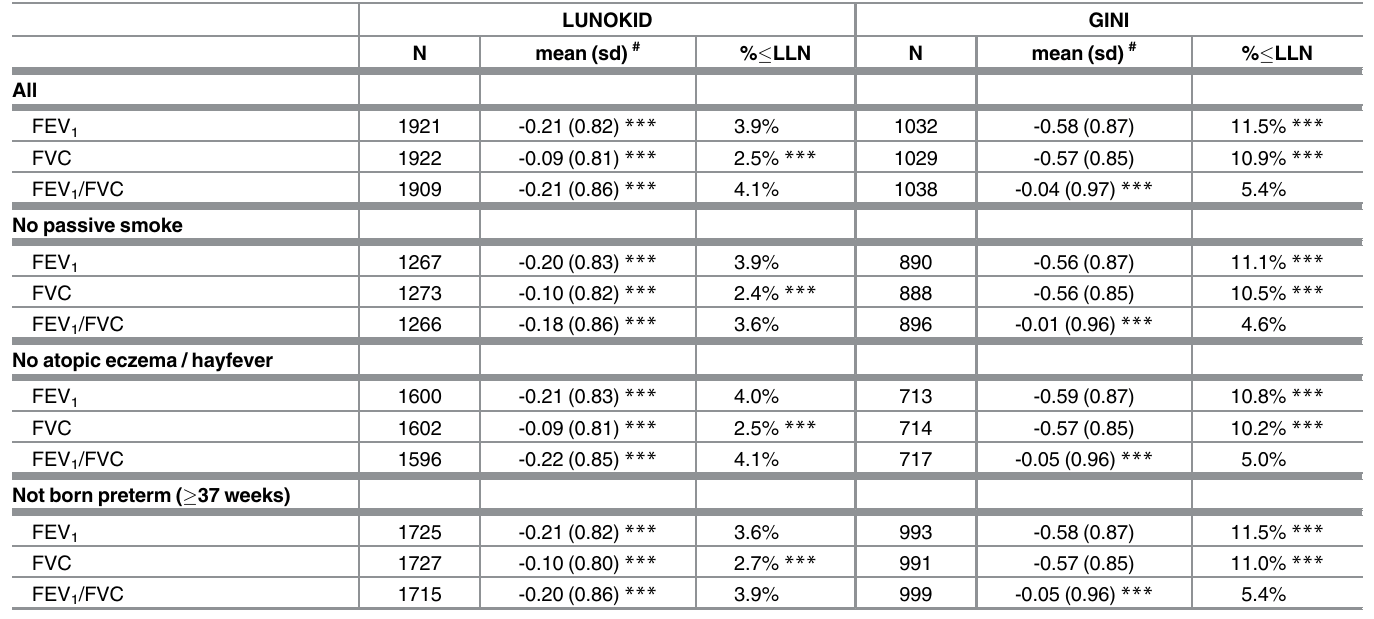
Caucasians from Australia and New Zealand (n = 2066, age: 4 – 80 years). In our previous study on the applicability of the GLI reference values for longitudinal data of elderly women from the German SALIA study, we came to the same conclusion (n = 1726, mean age of 54 years at base- line examination) [25]. In contrast, Ben Saad et al . found that the GLI reference values were of less value for adult North African Caucasians in Tunisia (n = 489, age: 18 – 60 years) [8]. Age Table 5. GLI-z-scores in GINIplus and LUNOKID in all lung healthy children (All) and in subgroups after using stricter exclusion criteria. LUNOKID GINI